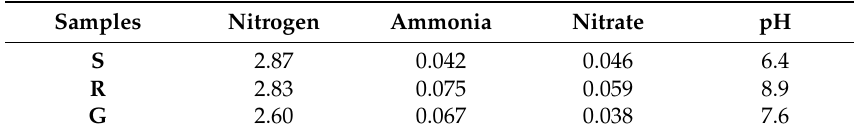
Table 3. Total nitrogen, ammonia, nitrate (Values in g/kg), and pH of cave sediment (S), gravel-like (G), and rock (R)